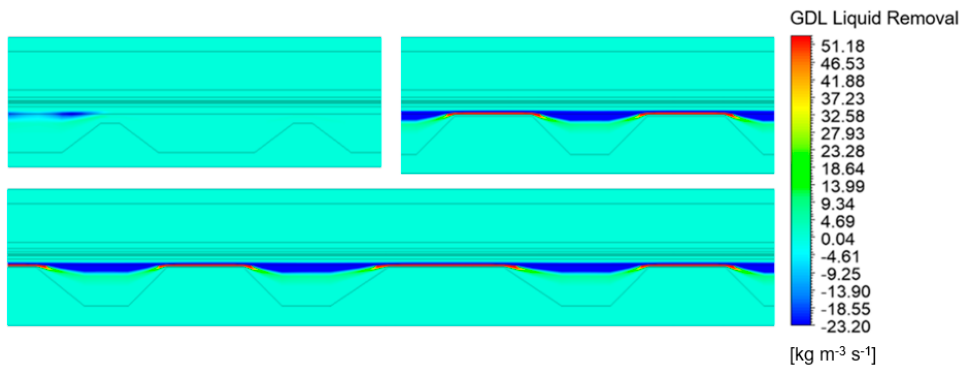
Figure 15. GDL liquid removal contours for reference case [17] ( above left ), Case #45 ( above right ) and Case #45d ( below ) at current density of 4.0 A cm − 2 .